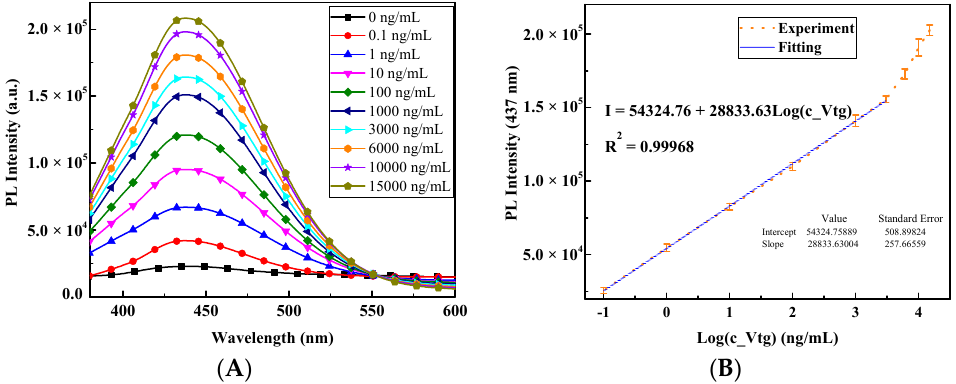
Figure 6. ( A ) PL “ON” of Anti-Lv-mAb/CQDs/RGO_PDDA after addition of different concentrations of Vtg (0.1, 1.0, 10, 100, 1000, 3000, 6000, 10,000, and 15,000 ng/mL); ( B ) the PL regaining intensities with the logarithm concentrations of Vtg; the linear range is from 0.1 ng/mL to 3000 ng/mL. Table 1. Comparison the LODs and test ranges for various immunosensing methods for Vtg/Lv detection.